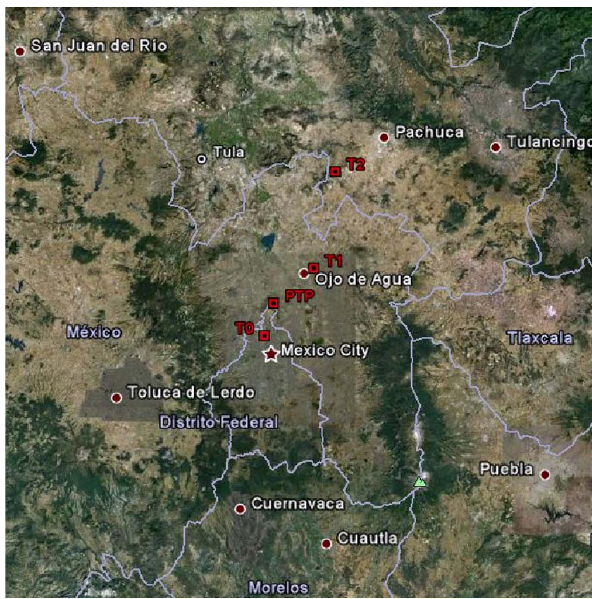
Fig. 1. The modeling domain for the Mexico City Metropolitan Area during the MILAGRO campaign. Also shown, the locations of the monitoring stations during the campaign.